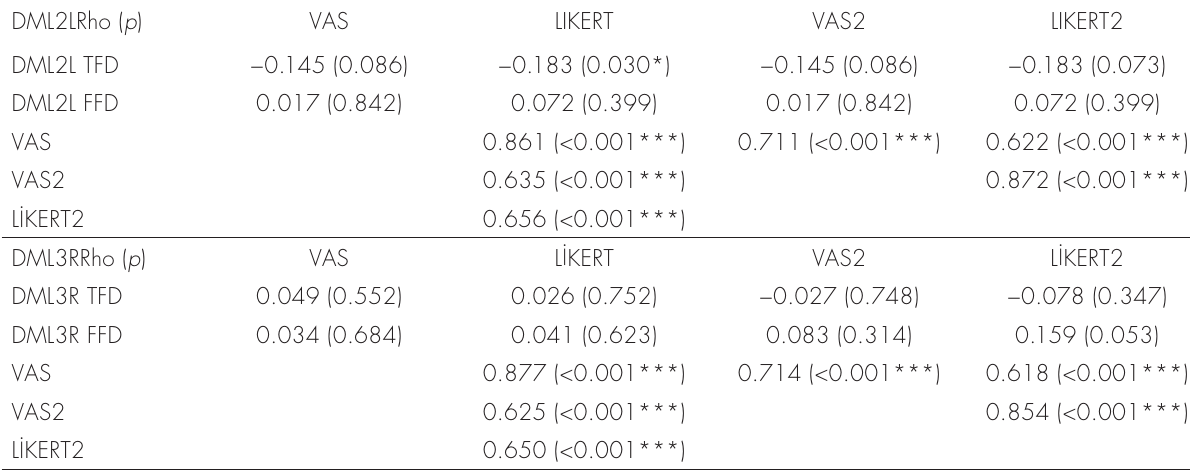
Table IV. The repeated photographs correlations between datasets of eye-tracking, VAS, and Likert scale. DML2LRho ( p ) VAS LIKERT